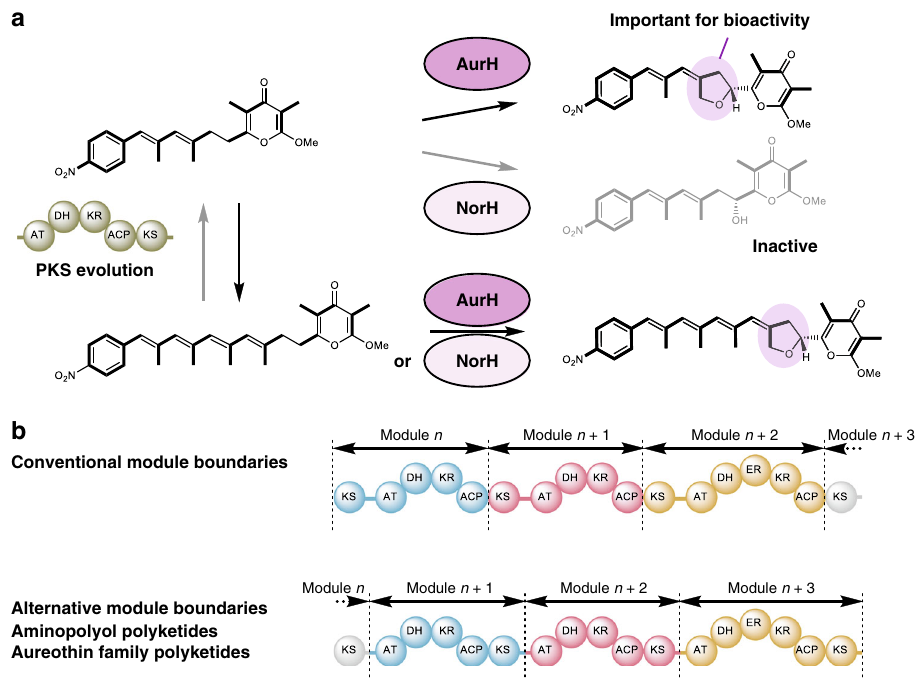
Fig. 6 Model of plausible evolutionary processes in the aur/nor modular type I PKSs and tailoring enzymes. a Insertion of two additional modules yields a functional nor assembly line in which bioactivity is maintained. b Scheme showing paradigm shift related to conventional and alternative PKS module boundaries that are in line with the proposed module insertions into the KS-AT linker